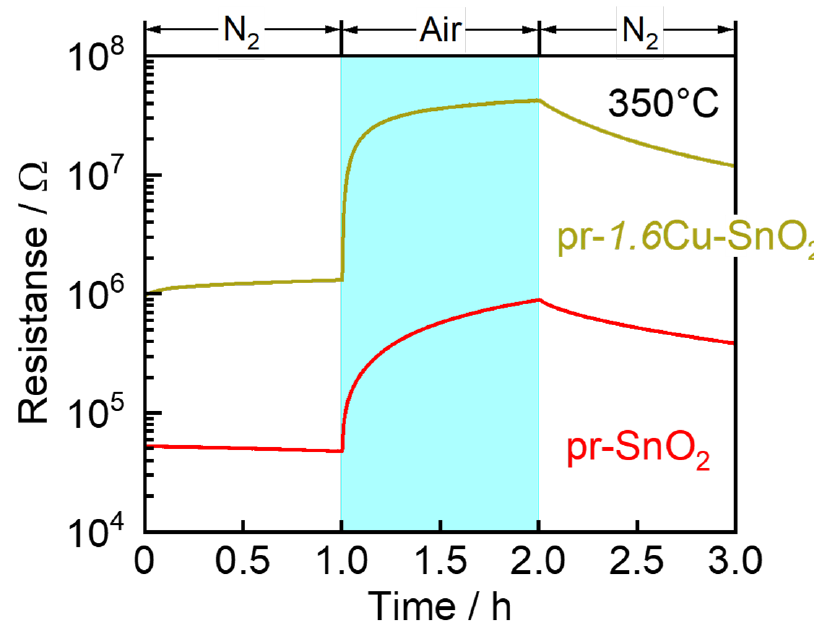
Figure 9. Response transients to dry synthetic air (21% O 2 ) of pr-SnO 2 and pr- 1.6 Cu-SnO 2 sensors in dry N 2 .